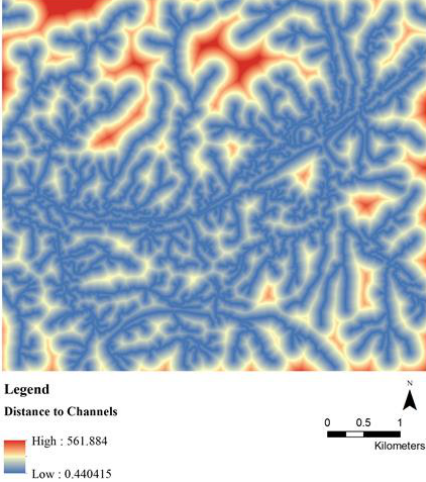
Figure 11. Distances to